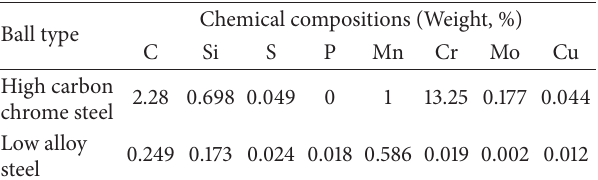
Table 2: Chemical compositions of the grinding